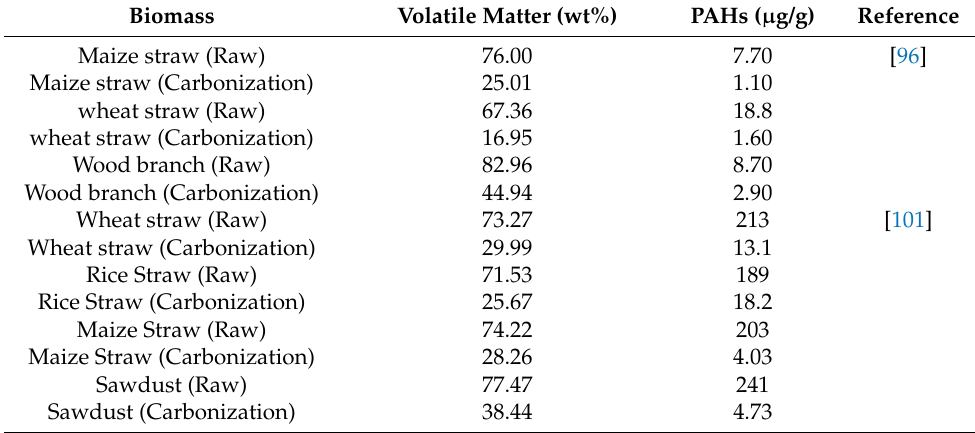
Table 9. The emission of PAHs under the burning of same biomass contains different volatile matter in the same stove during the laboratory-simulated stove